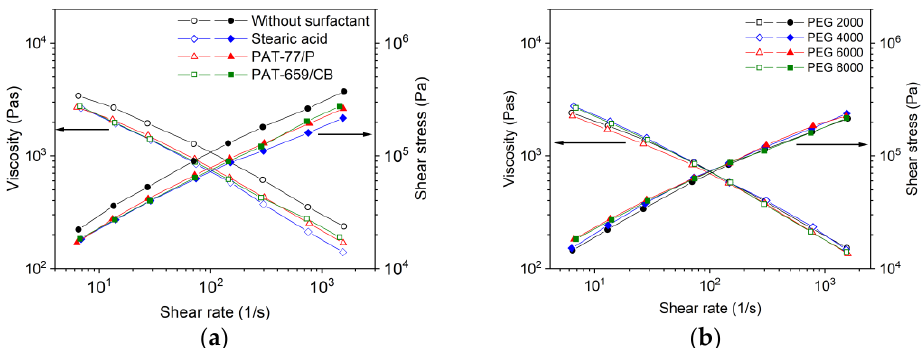
Figure 10. ( a ) Shear rate dependent melt viscosity as well as shear stress at 160 °C of PEG8000/PMMA-based binder (solid load 60 vol%) and different surfactants; ( b ) variation of the PEG M W with 5 wt% SA as surfactant (solid load 60 vol%, 160 °C).